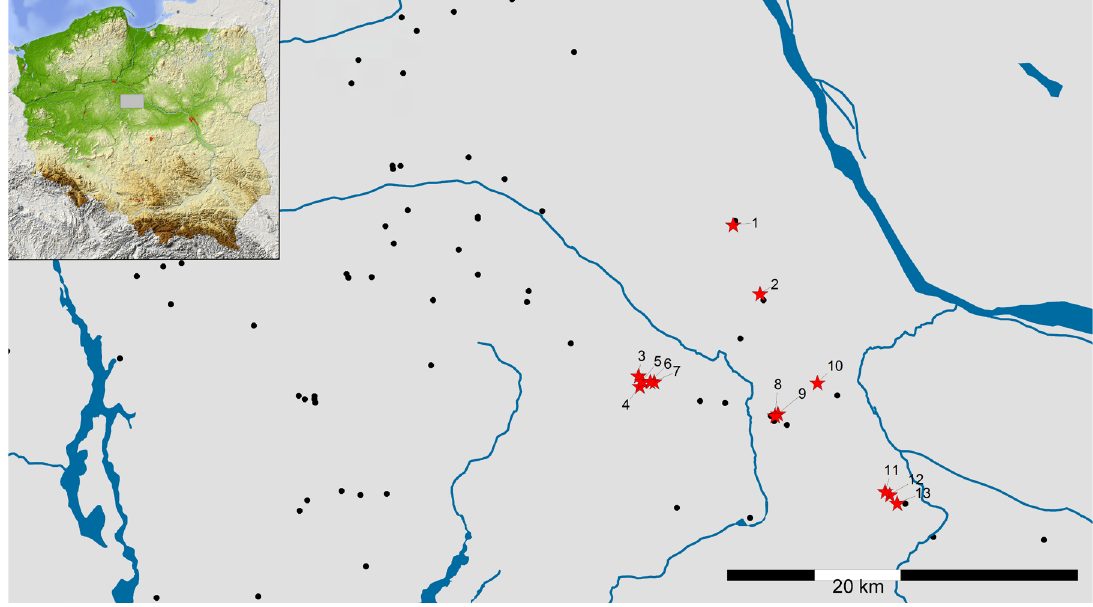
Fig. 2 . Sites of the BKK in the Brześć Kujawski region. Sites mentioned in the text: 1- Bodzia 1, 2- Dubielewo 8, 3- Konary 1, 4- Osłonki 1, 5- Konary 1, 6- Miechowice 4a, 7- Miechowice 4, 8- Brześć Kuj. 4, 9- Brześć Kuj. 3, 10- Pikutkowo 6a, 11- Kruszynek 6, 12- Ludwinowo 3, 13- Ludwinowo